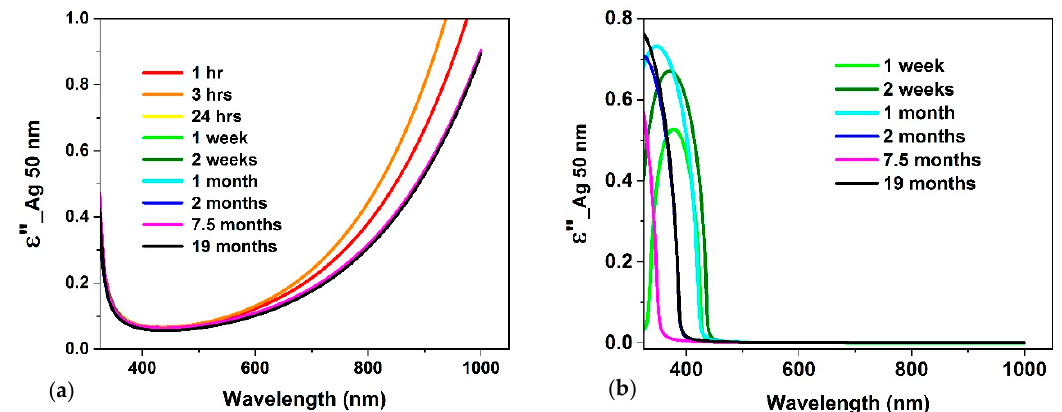
Figure 10. Dielectric permittivity imaginary part evolution for the 50 nm Ag thin films: ( a ) main layer; ( b ) roughness layer in the range of 330–1000 nm.